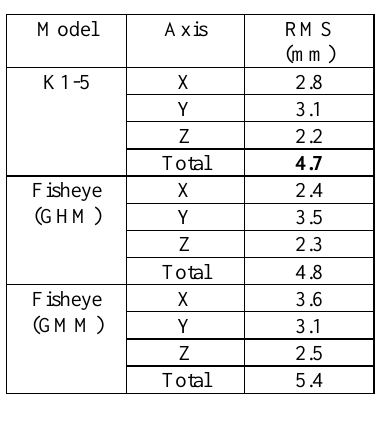
Table 8. RMS of object-space residuals on checkpoints for GoPro camera in check adjustment using parameters estimated from various models, based on checkerboard pattern